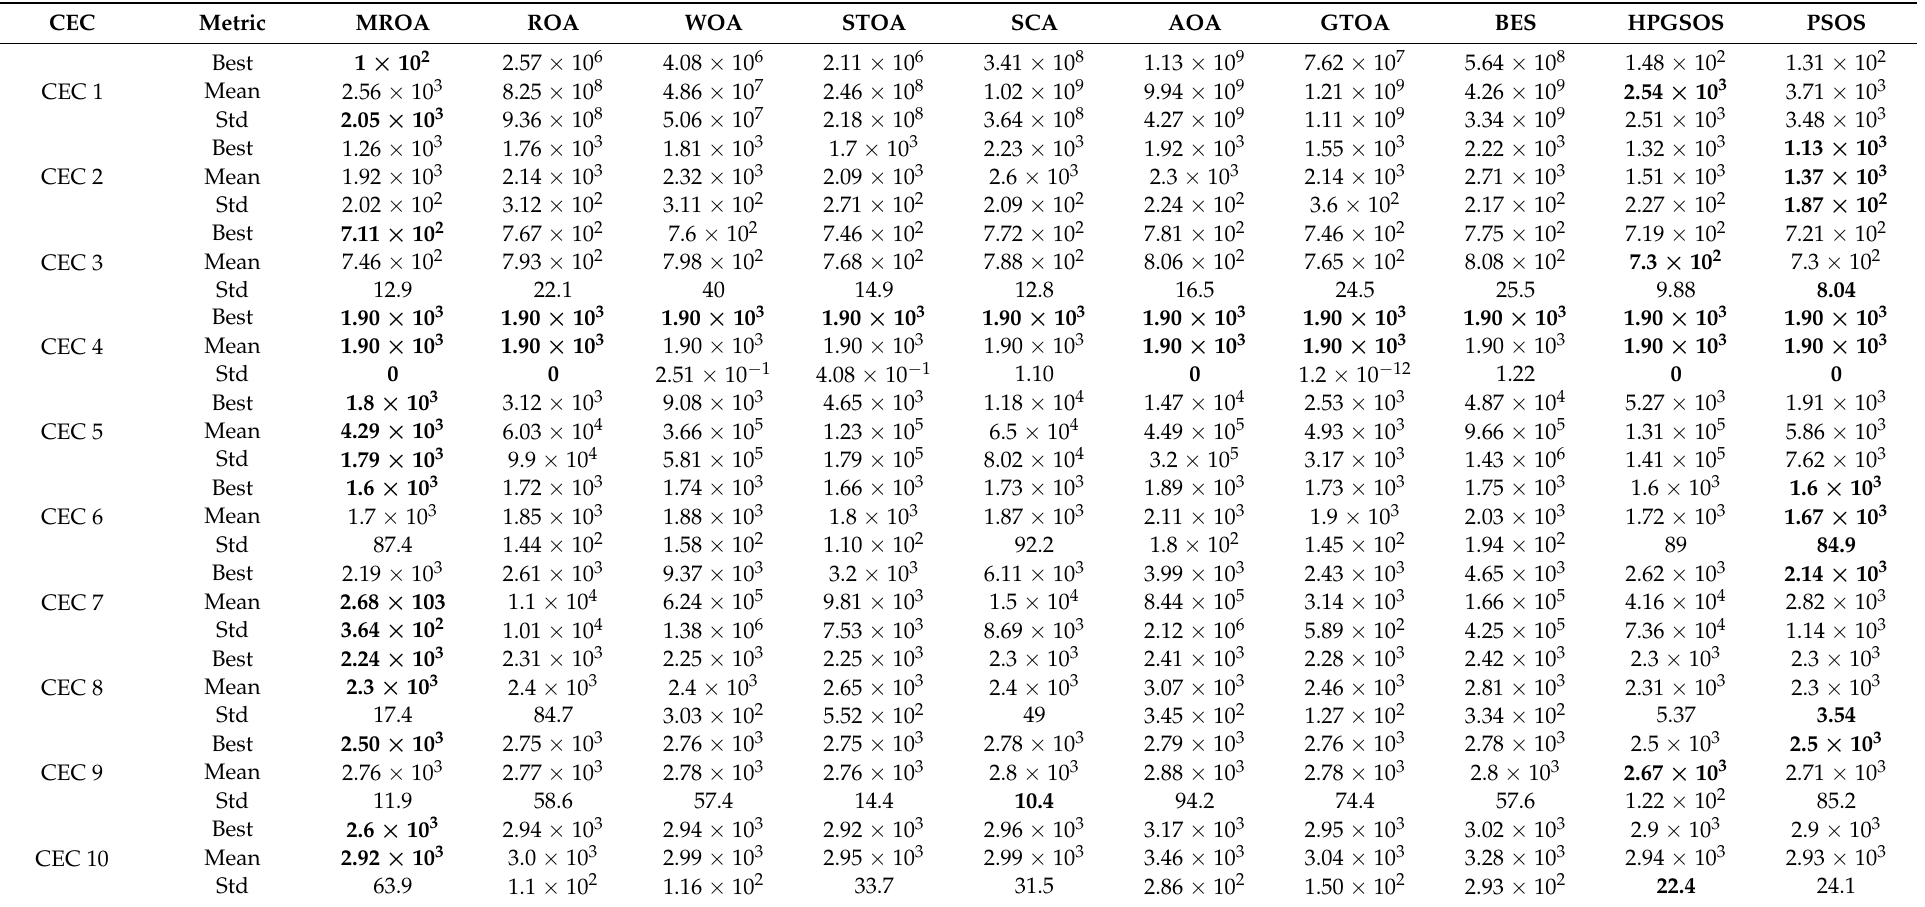
Table 8. Results of the MROA and other metaheuristic algorithms on test functions (CEC 1–CEC 10) with dim = 10 (run 30 times). (Bold means good